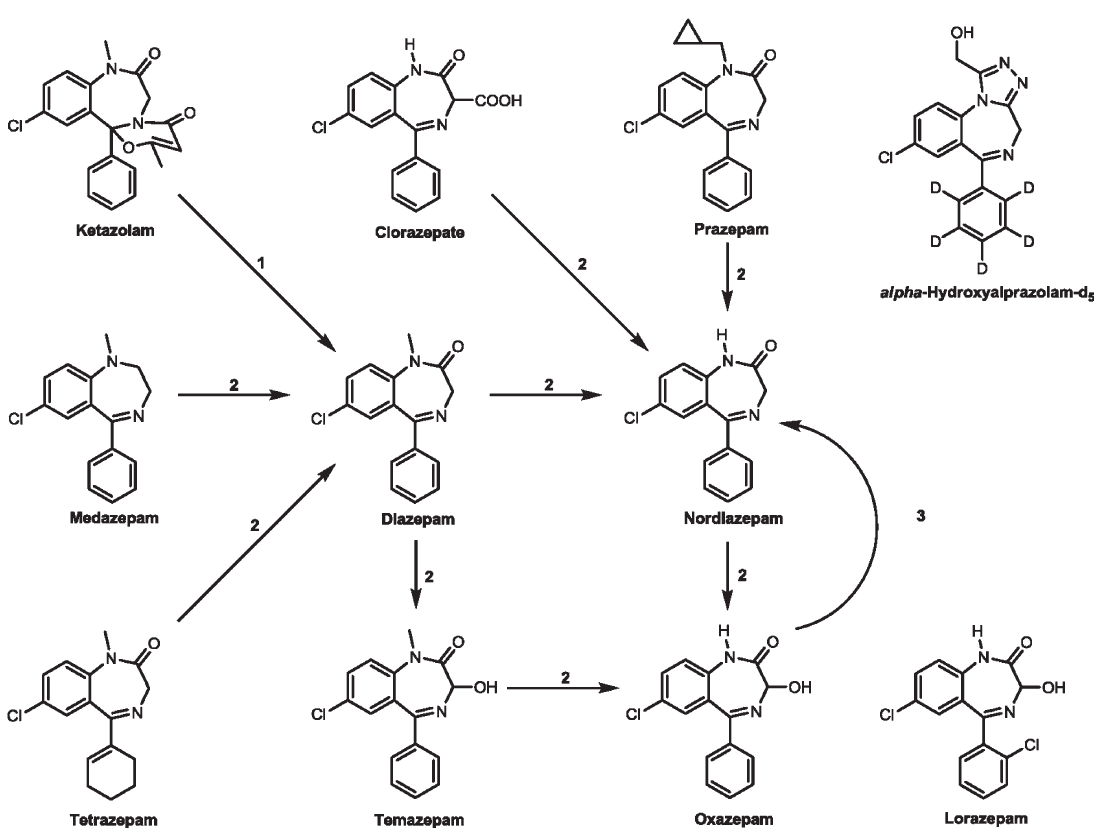
Figure 2. Transformation of benzodiazepines during enzymatic